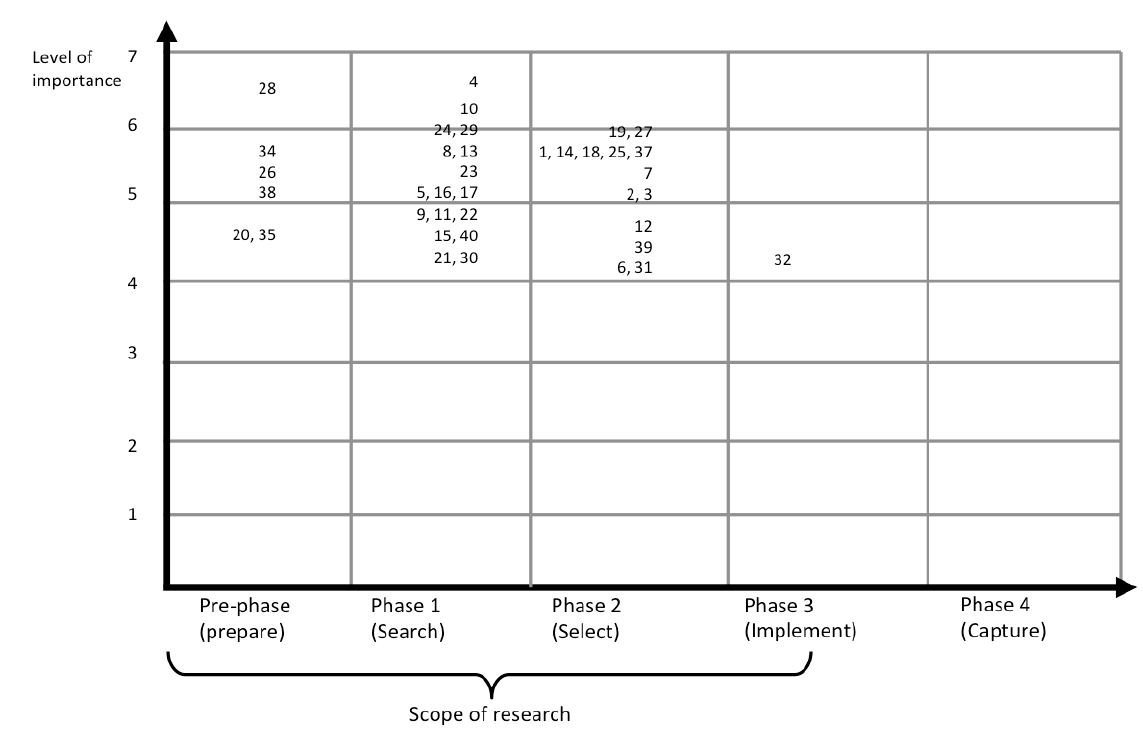
Fig. 5. The figure demonstrates when the facilitator’s characteristics are most important in innovation projects, according to the teams on